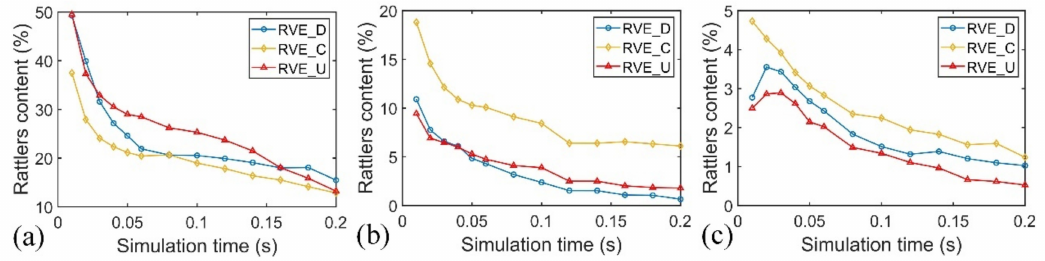
Figure 6. Evolution of rattler contents for specimen ( a ) FC30; ( b ) FC40; and ( c ) FC60.